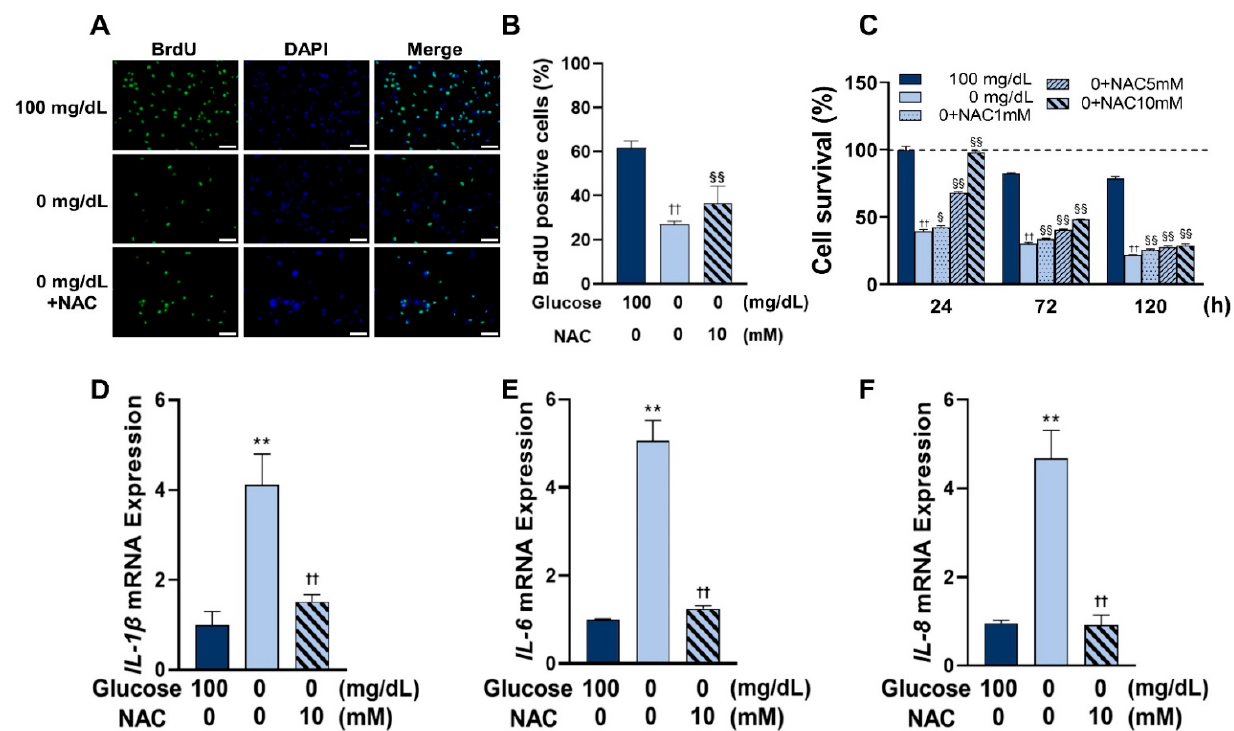
Figure 5. NAC rescued the cellular viability and reduced inflammation in HGnFs induced by low glucose conditions. ( A , B ) Representative immunofluorescence images of BrdU were incorporated into DNA after the addition of 10 mM NAC, and the nuclei were stained by DAPI. The quantitative analysis of BrdU-positive cells was presented as mean ± SD of three independent experiments. ( C ) Cell survival after the addition of 10 mM NAC was measured using an MTT assay. The average of the absorbance of each group at 0 h was used as 100% to calculate the relative results. ( D – F ) The mRNA expression of inflammatory cytokines, such as IL-1 β , IL-6, and IL-8, was determined using real-time PCR in stimulated HGnFs incubated for 72 h. (Scale bars: 100 μ m; a significant increase compared with the control was described as ** p < 0.01; a significant increase compared with the 0 mg/dL group was described as § p < 0.05, §§ p < 0.01; a significant decrease compared with the group of 0 mg/dL was described as †† p < 0.01.) .